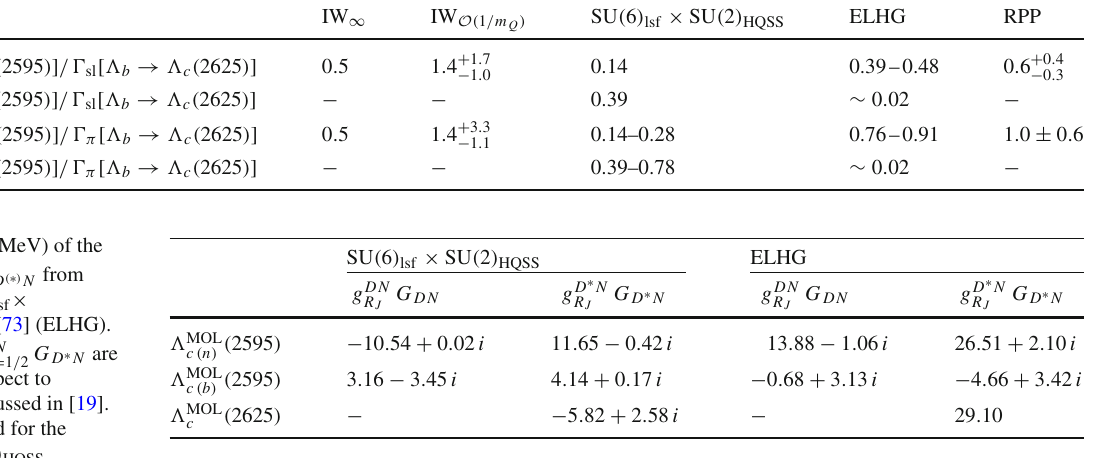
Table 2 Ratios of semileptonic ( μ − ¯ ν μ or e − ¯ ν e ) and pion (cid:2) b decays into odd parity J = 1 / 2 and 3 / 2 charm baryons. We show predictions obtained from the molecular schemes of Refs. [66,67] (SU ( 6 ) lsf × SU ( 2 ) HQSS ) and [73] (ELHG), together with the m Q → ∞ limit (IW ∞ ) ratios, and those found including the subleading corrections [IW O ( 1 / m ] derived in Ref. [14] for the case of a j P q = 1 − HQSS Q ) doublet. The ELHG results for the narrow (cid:2) c ( 2595 ) are taken from